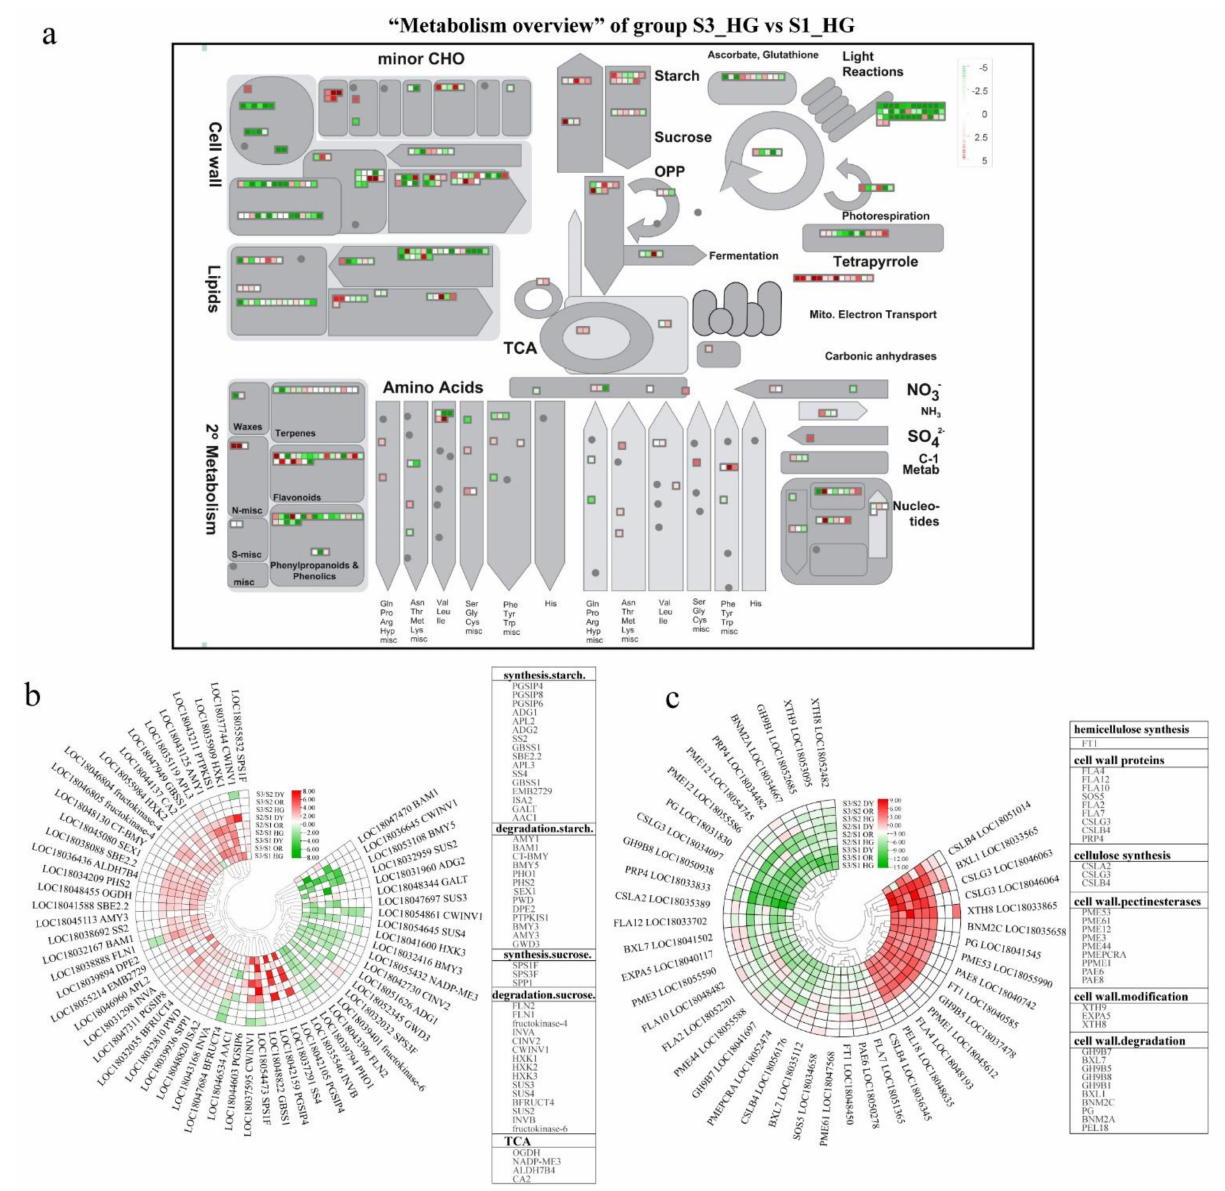
Figure 7. ( a ) MapMan-based “metabolic overview map” of DEGs in the “S3_HG vs. S1_HG” group, including lipid, cell wall, secondary metabolism, starch, sucrose, tricarboxylic acid (TCA) cycle, amino acid, and light reaction components. The small heat map in each section of the diagram shows the DEGs mapped to that pathway, and a small square indicates a gene. The color of the square indicates the expression of the gene at S3, with green and red indicating down-regulation and up-regulation, respectively. ( b ) Differentially expressed genes (DEGs) related to starch, sucrose, and TCA metabolism during tangor fruit development and ripening. ( c ) DEGs related to cell wall metabolism during tangor fruit development and ripening. Heatmap of DEGs was drawn using the log 2 Foldchange value obtained from the pairwise comparison of samples. S3/S1, comparison group of S3 and S1; S2/S1, comparison group of S2 and S1; S3/S2, comparison group of S3 and S2. Red and green indicate up-regulation and down-regulation, respectively, in the former of the